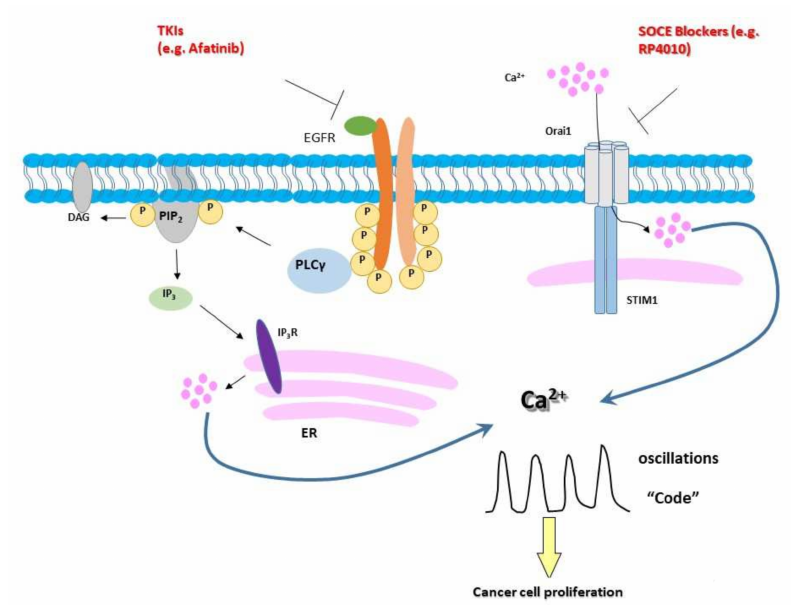
Figure 6. Illustration of intracellular Ca 2+ oscillations as the intersection between EGFR and SOCE signaling pathways. [Ca 2+ ]cyto are dependent on EGFR/PLC γ /IP 3 /IP 3 R-mediated ER Ca 2+ release and Orai1-mediated SOCE. Intracellular Ca 2+ oscillations are code, especially the frequency, to control cell proliferation in ESCC cells. Inhibiting either EGFR by Afatinib or Orai1 by RP4010 could reduce the frequency of intracellular Ca 2+ oscillations and inhibit cancer-cell